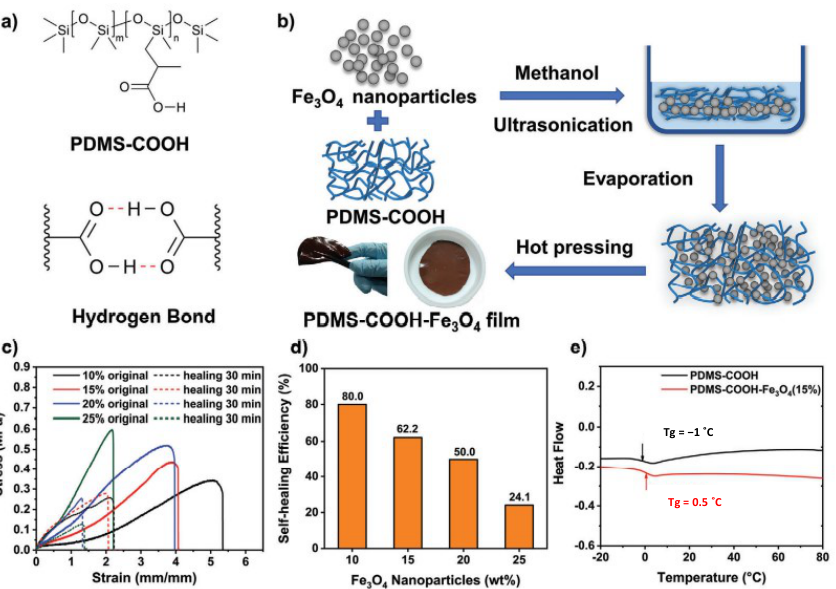
Figure 3. A sketch of the preparation and characterization of the PMMS-COOH-Fe 3 O 4 polymer. ( a ) The chemical structure of the PDMS-COOH polymer. ( b ) the Schematics for the preparation process. ( c ) The stress-strain results for both the initial and healed polymers. ( d ) The self-healing efficiency of the PDMS-COOH at loading weights from 10 to 25 wt%. ( e ) DSC thermograms of PDMS-COOH and PDMS-COOH-Fe 3 O 4 (15 wt%). Adapted with permission from [30] . Copyright 2021, John Wiley and Sons.